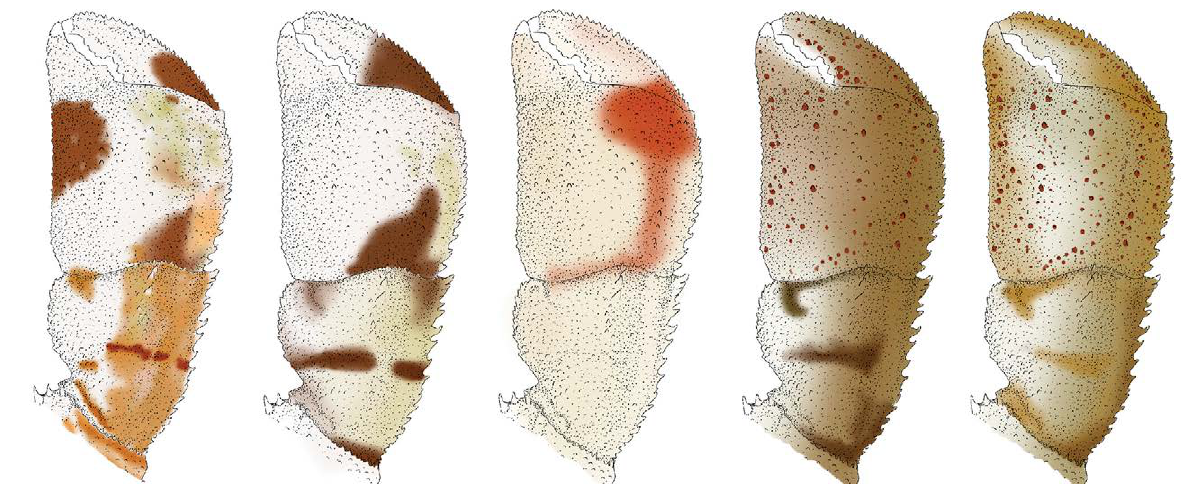
Fig. 15. – Different colour patterns of Diogenes pugilator chelipeds. Vectorial drawings are originals from Almón et al.